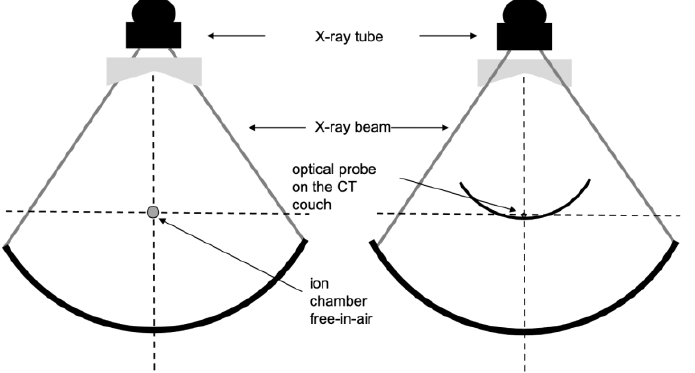
Figure 1. Diagram demonstrating practical measurement of weighted CT air kerma index ( CTDI w ) for beam width < 40 mm with a 100 mm CT chamber ( left ) and IVIscan detector ( right ). The phantom is placed on the CT table in both cases.